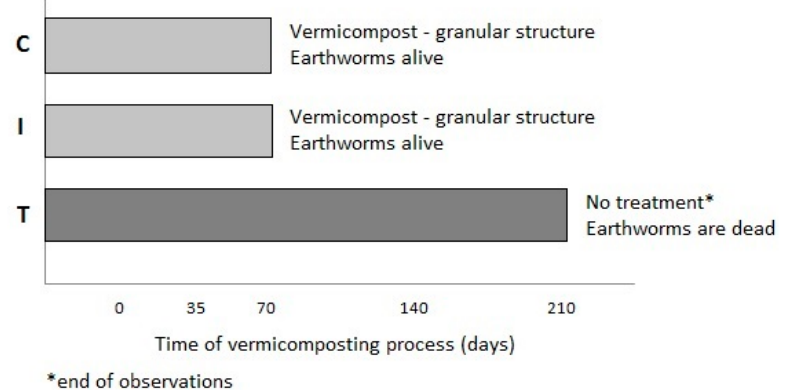
Figure 1. Duration of vermicomposting of plant waste.